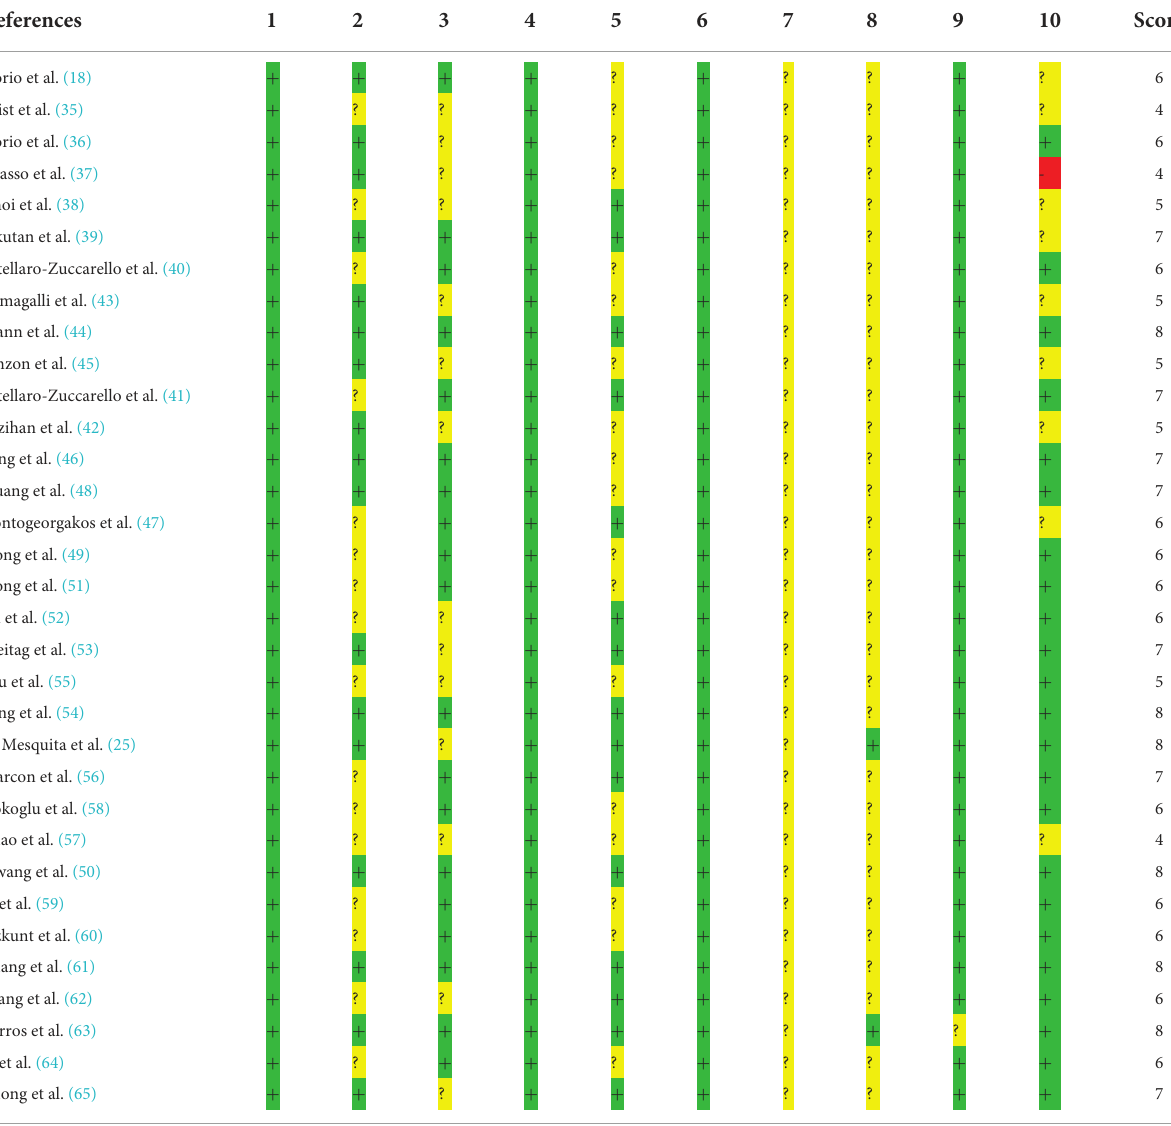
TABLE 2 Risk of bias in included studies accessed by